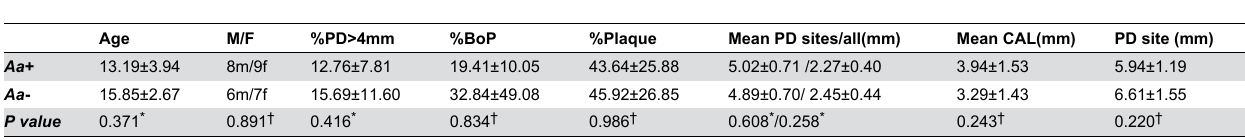
Values are given by Means ± Standard deviation. M=male; F=female; Mean PD sites= Mean pocket depth of sites with PD>4mm; Mean PD all= mean PD of all sites; CAL=clinical attachment level of affected sites; BoP=bleeding on probing; PD site = Pocket depth from site sampled for microbiological analysis. *t-test; † Mann-Whitney Rank Sum